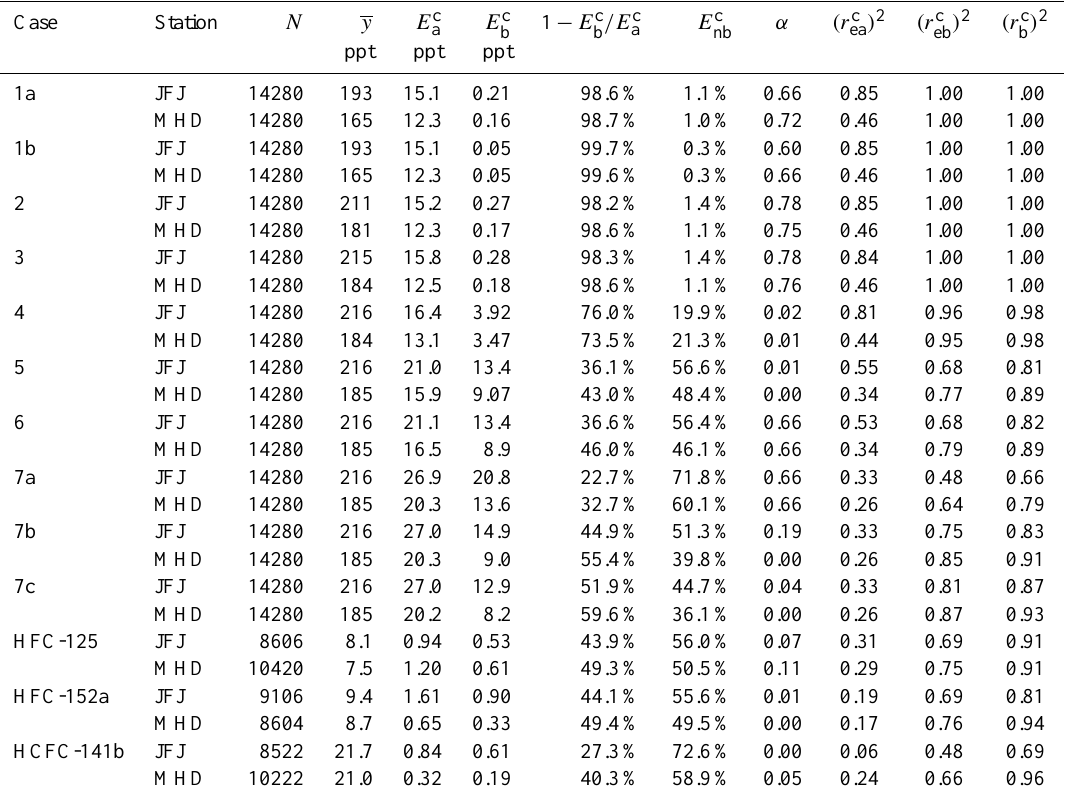
Table 3. Error statistics for different inversions from synthetic (cases 1-7) and real observations (cases HFC-125, HFC-152a, HCFC- 141b). y are 2006–2010 mean concentrations, N the number of observations, E c a and E c observed concentrations for the a priori and a posteriori emissions, respectively, α the 1st order autocorrelation of the residuals, E c posteriori error normalized by the standard deviation of the observed concentration minus baseline, and r 2 are the squared Pearson correlation coefficients between a priori minus baseline and observation minus baseline ( (r c ea ) 2 ), a posteriori minus baseline and observation minus